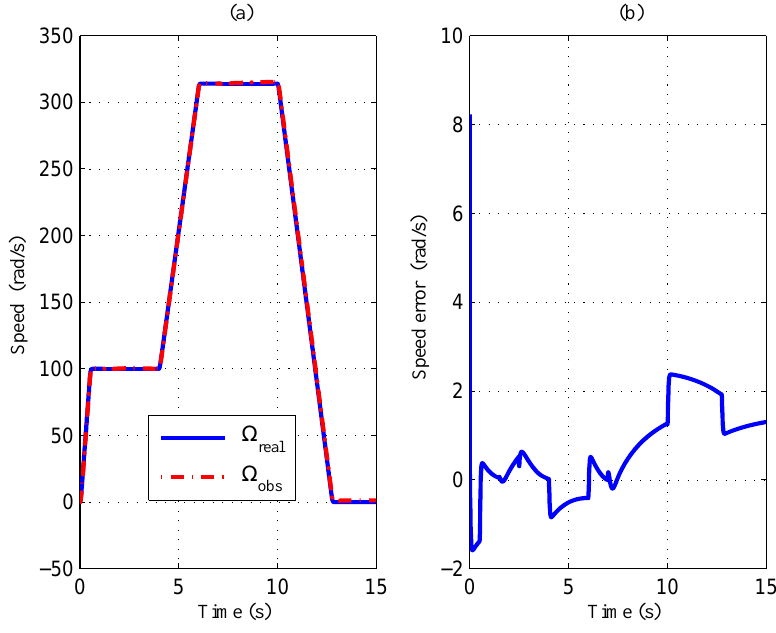
Figure 12. Robustness w.r.t. − 20% L d , L q : ( a ) observed and measured speeds; and ( b ) speed